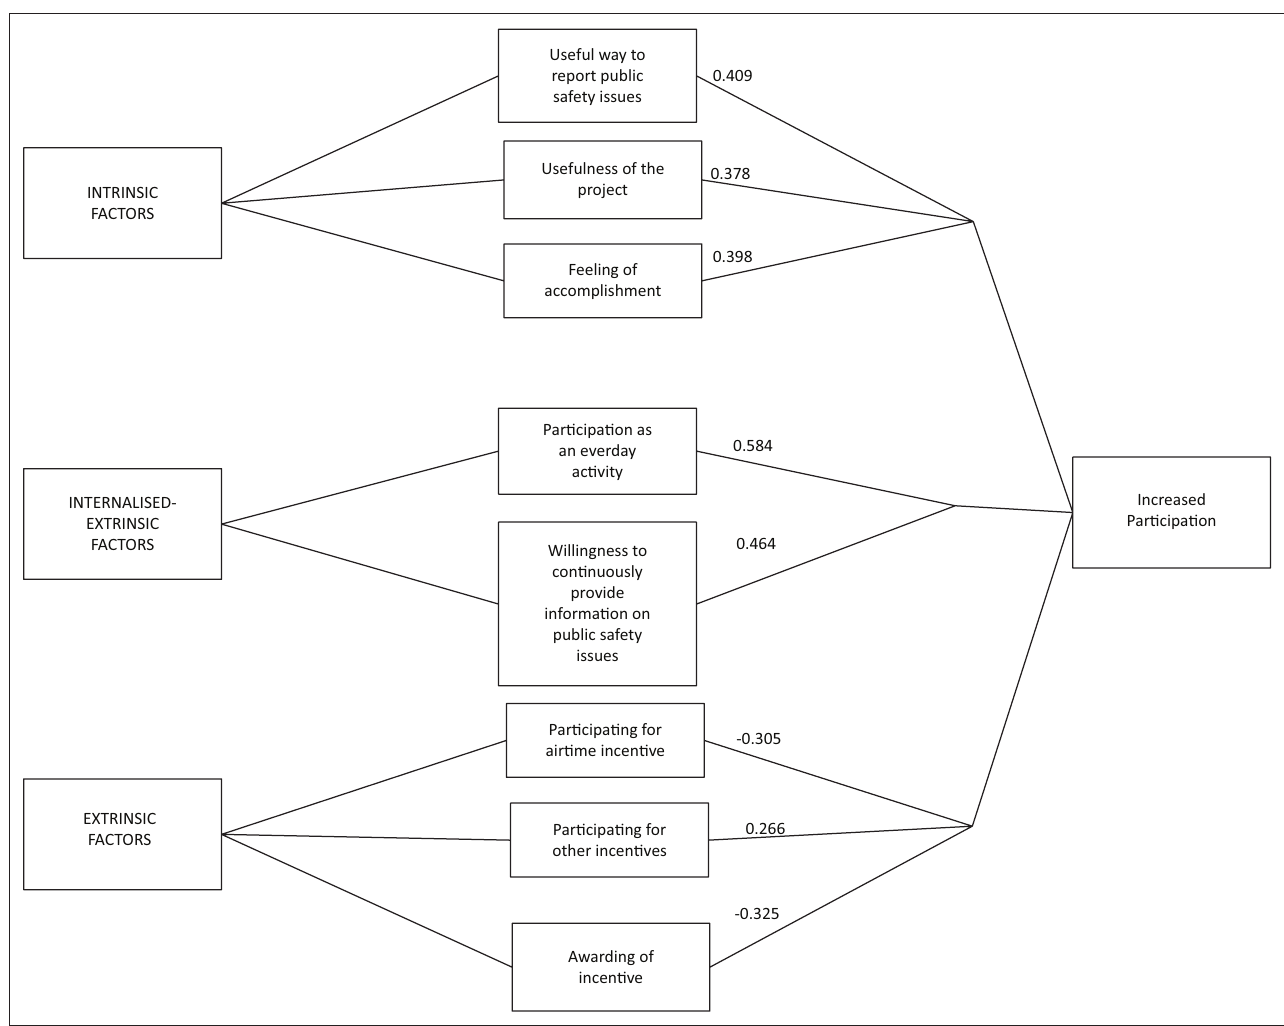
FIGURE 3: Participatory Crowdsourcing Incentive